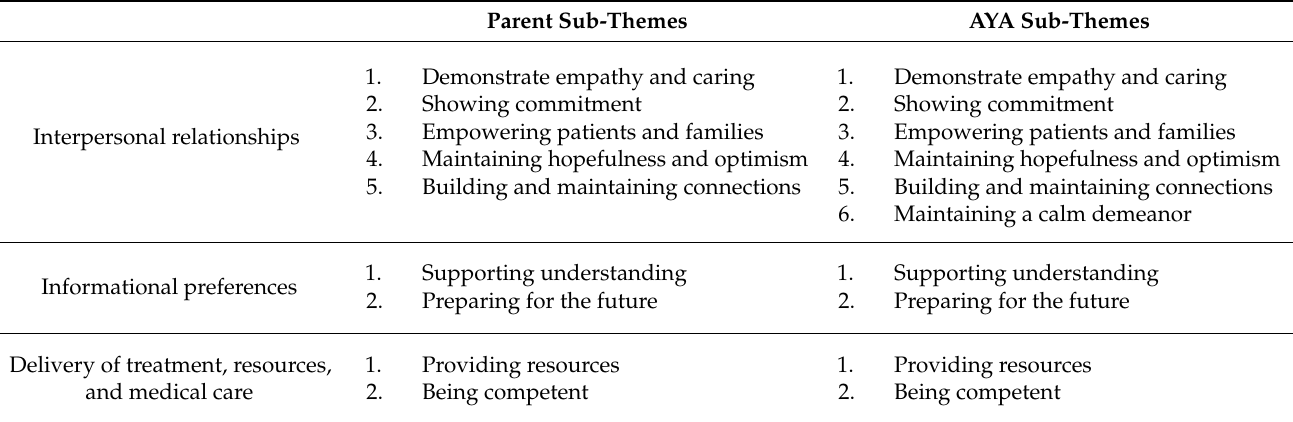
Table 3. Three major themes and